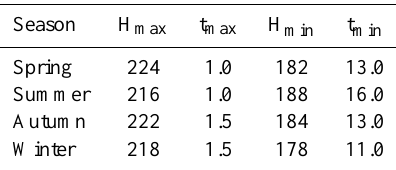
Table 3. Harmonic components of fitting mean, annual and semi- annual variations of LTH according to Eq. (1). Amplitudes are in km, and phases in